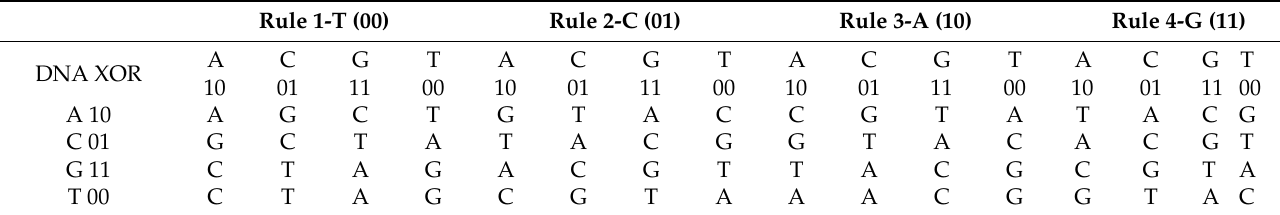
Table 3. DNA XOR rules.